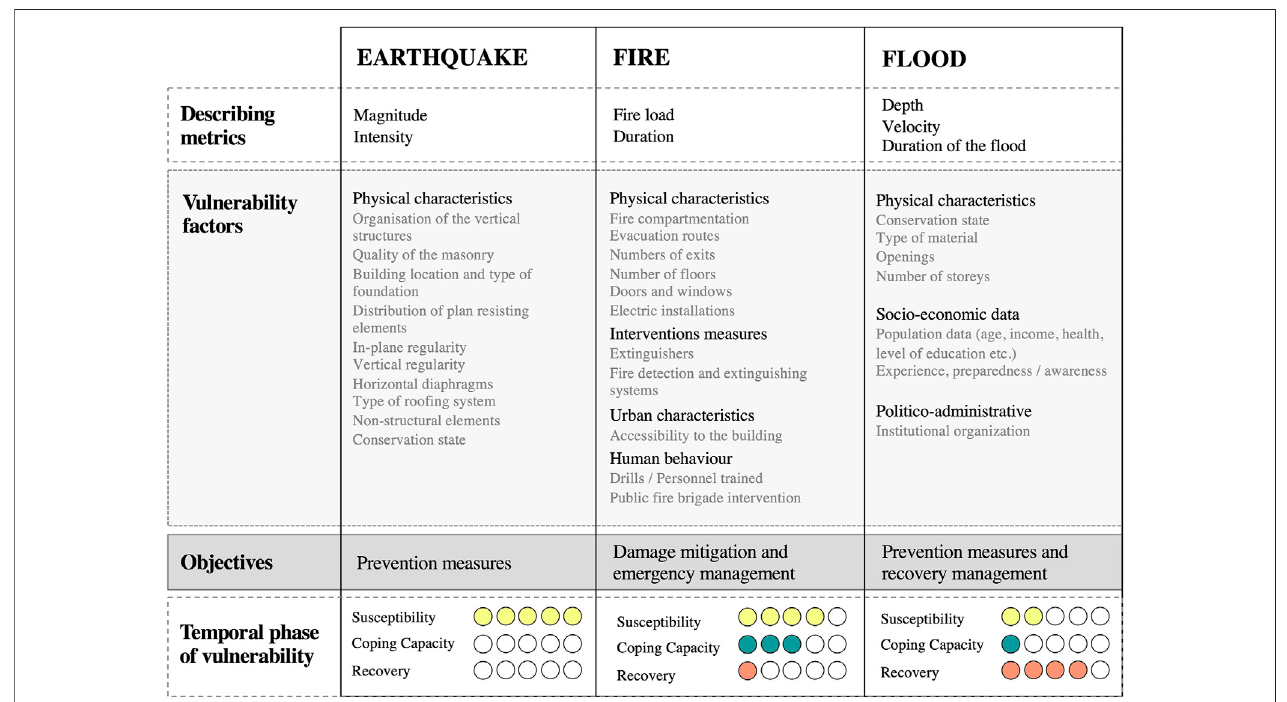
FIGURE 1 | Earthquakes, fi re and fl ood as hazardous events for buildings and